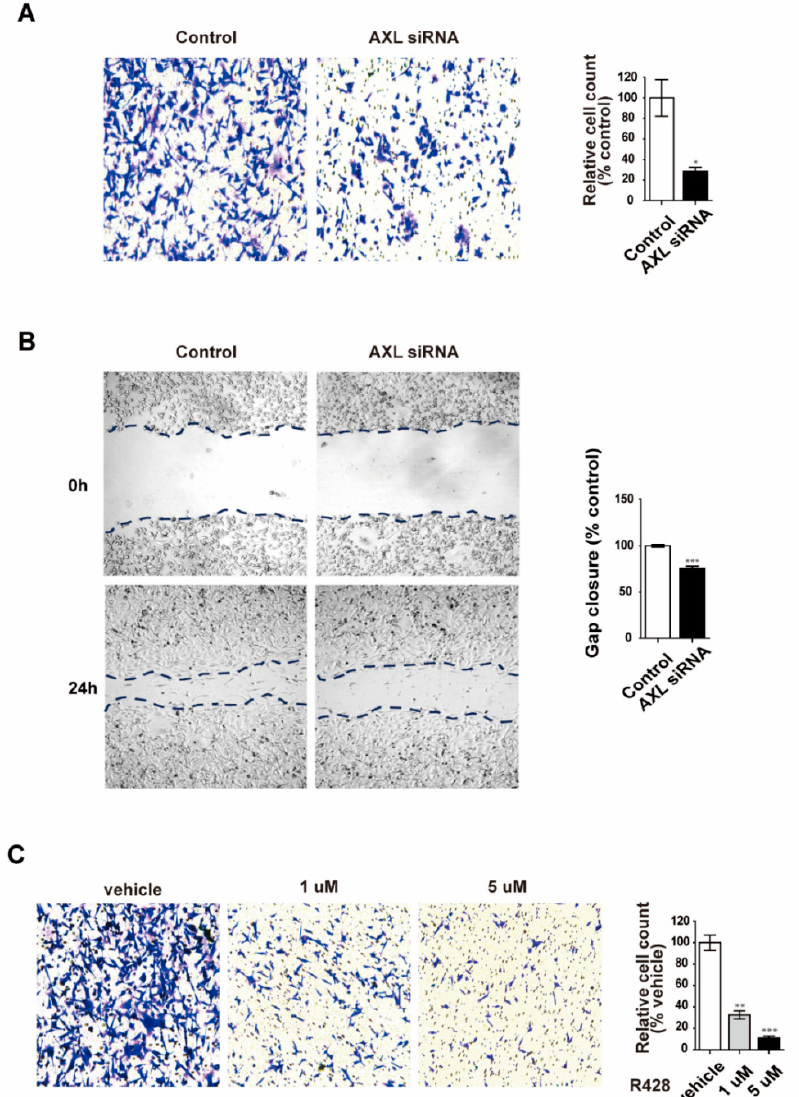
Figure 3. Inhibition of AXL suppresses cell invasion and migration in MDA-MB-231 breast cancer cells. ( A ) Inhibition of invasion ability in MDA-MB-231 breast cancer cells after AXL knockdown. ( B ) MDA-MB-231 breast cancer cell migration inhibition following AXL knockdown. ( C ) Inhibition of invasive ability in R428-treated MDA-MB-231 breast cancer cells. * p < 0.05, ** p < 0.01, *** p < 0.001 versus controls, calculated using unpaired two-tailed Student’s t -test. Error bars, S.E.M. 3.4. Overexpression of AXL Promotes Vasculogenic Mimicry Formation and Regulates